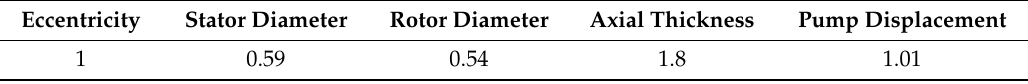
Table 4. Parameters of the pump with respect to the reference unit M0.